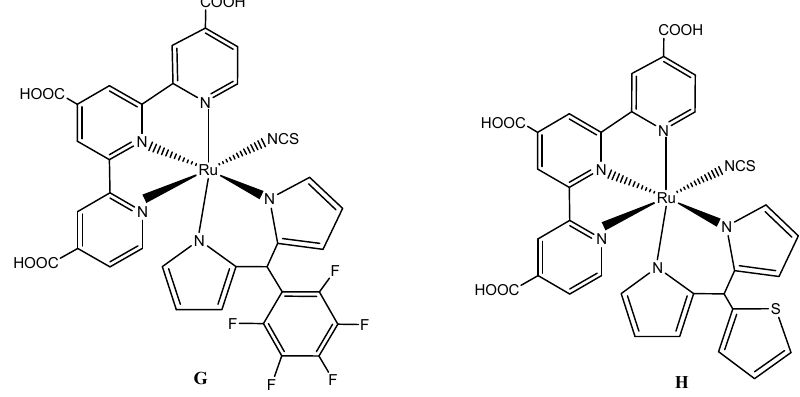
Figure 8. Coordination of bidentate 5-pentafluorophenyldipyrrinate (pfpdp) or 5-(2-thieny) dipyrrinate (2-tdp) to a Ru(II) centre bearing terpyridyl tricarbonate and NCS